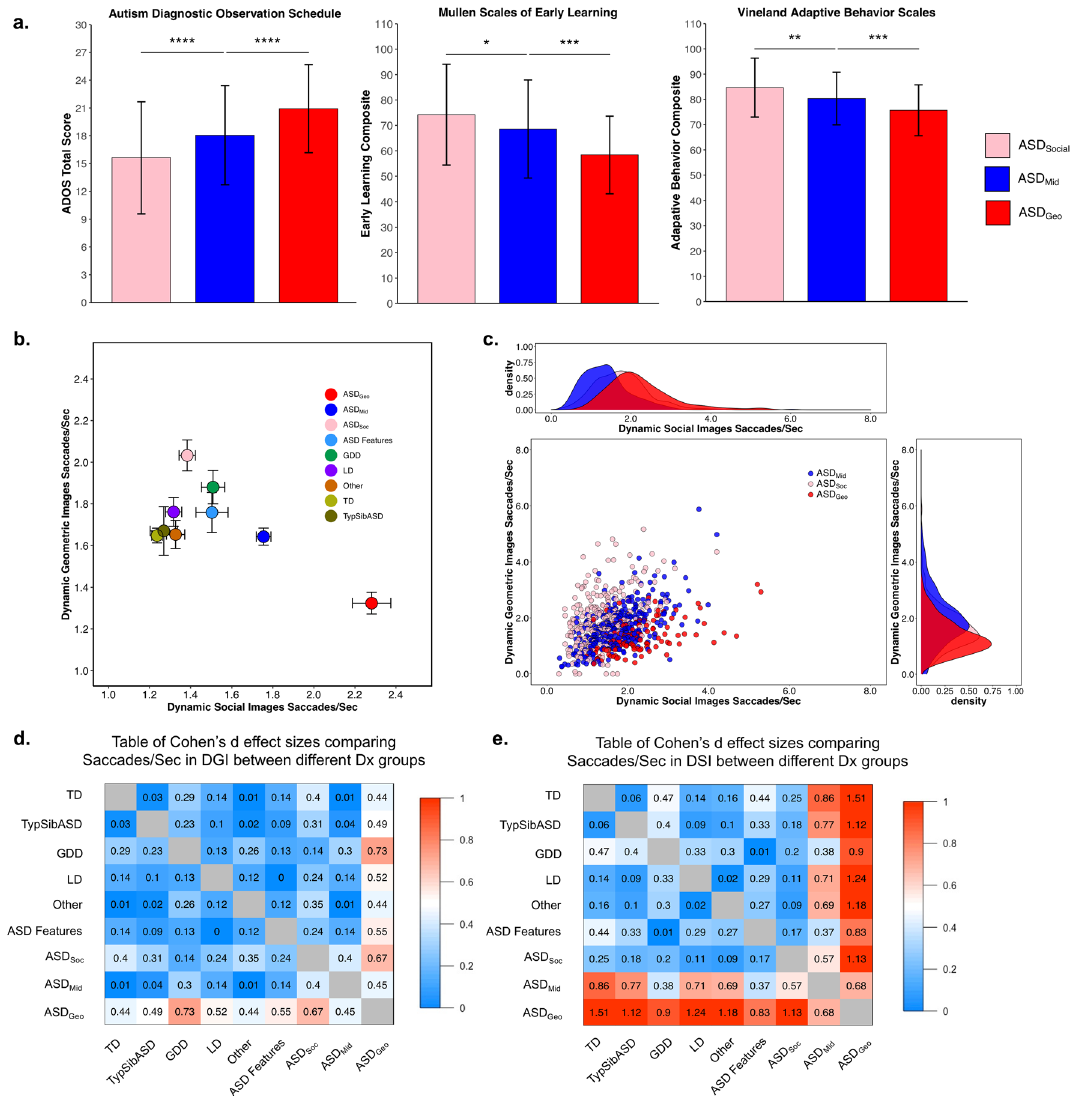
Figure 2. Differences in clinical and saccade profiles across ASD subgroups. ( a ) Bar graphs (mean ± SD) demonstrating clinical scores obtained from ASD toddlers with varying levels of preference for dynamic geometric images (DGI). ASD toddlers with a strong preference for DGI (≥ 69% fixation to DGI) were designated as ASD Geo . ASD toddlers with a strong preference for dynamic social images (DSI) (≥ 69% fixation to DSI) were designated as ASD Soc . Toddlers who lacked a strong preference for either stimulus were designated as ASD Mid toddlers. ( b ) Scatterplot showing average saccades/sec across diagnostic groups (mean ± SEM) to dynamic geometric images (DGI, y-axis) or dynamic social images (DSI, x-axis). ( c ) Scatterplot showing saccades/sec to DGI (y-axis) or DSI (x-axis) for all ASD subgroups. Density plots demonstrate distribution of individual saccade patterns to DGI or DSI. ( d , e ) Cohen’s d effect sizes associated with pairwise comparisons of average saccades/sec to DGI or DSI. ASD: Autism Spectrum Disorders, ASD-Feat: ASD Features, GDD: Global Developmental Delay, LD: Language Delay, TD: Typically Developing; TypSibASD: Typical Sibling of subject with